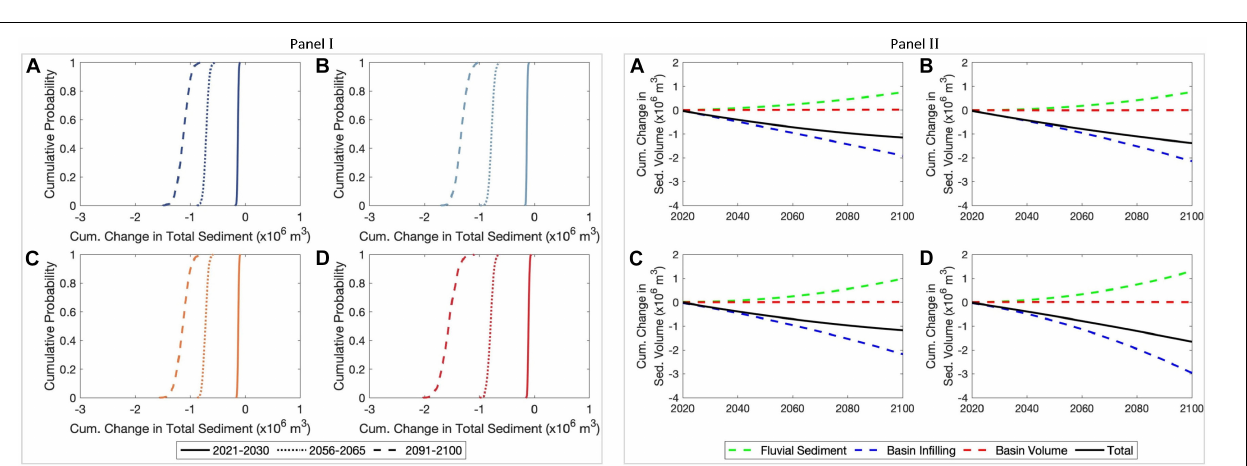
FIGURE 6 | Projected variation of change in total sediment volume exchange ( (cid:49) V T ) between the Alsea estuary and the adjacent coast over the 21 st century. The projected ranges between 10 th and 90 th percentile are shown as shaded bands with the variation of the 50 th percentile values indicated by the solid lines for RCP 2.6 (blue) and RCP 8.5 (red). The negative volumes indicate that the estuary traps more sediment at the expense of the open coast. Deterministic projections of (cid:49) V T presented in Bamunawala et al. (2020) for RCP 2.6 (blue) and RCP 8.5 (red) are indicated by the dashed lines. Vertical bars indicate the projected ranges between the 10 th and 90 th percentiles in 2100 for all RCPs with the 50 th percentile values indicated as horizontal lines.